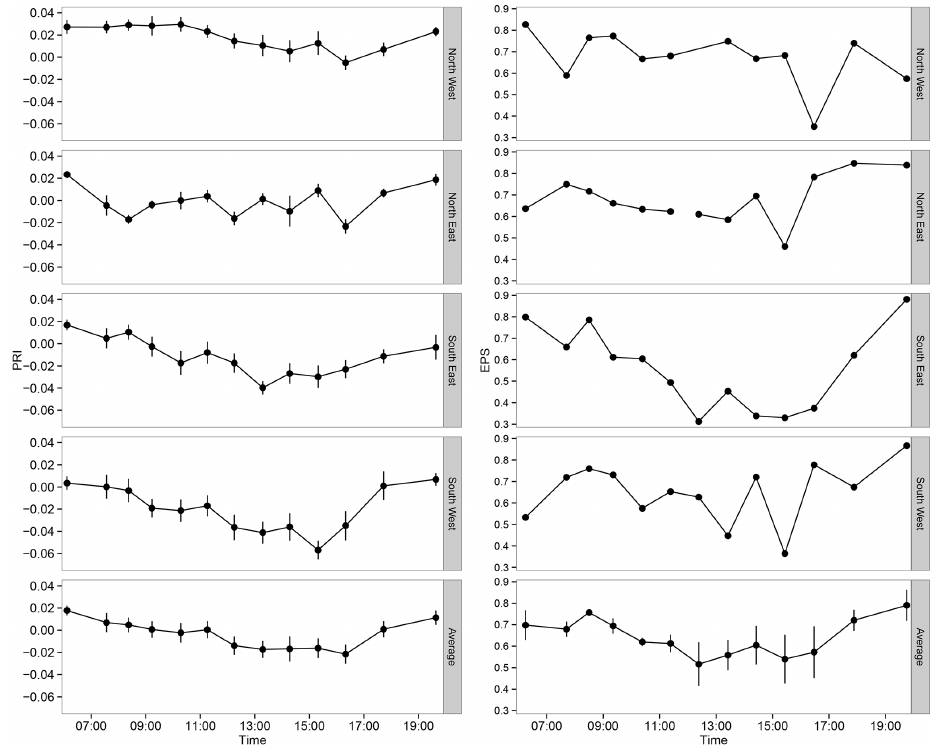
Figure 9. Diurnal course of lodgepole pine ( Pinus contorta ) leaf-level photochemical reflectance index (PRI) and the epoxidation state of the xanthophyll cycle components (EPS). PRI values for each of the four directions are means of 10 sampled spectra. Error bars represent ± 1 standard error of